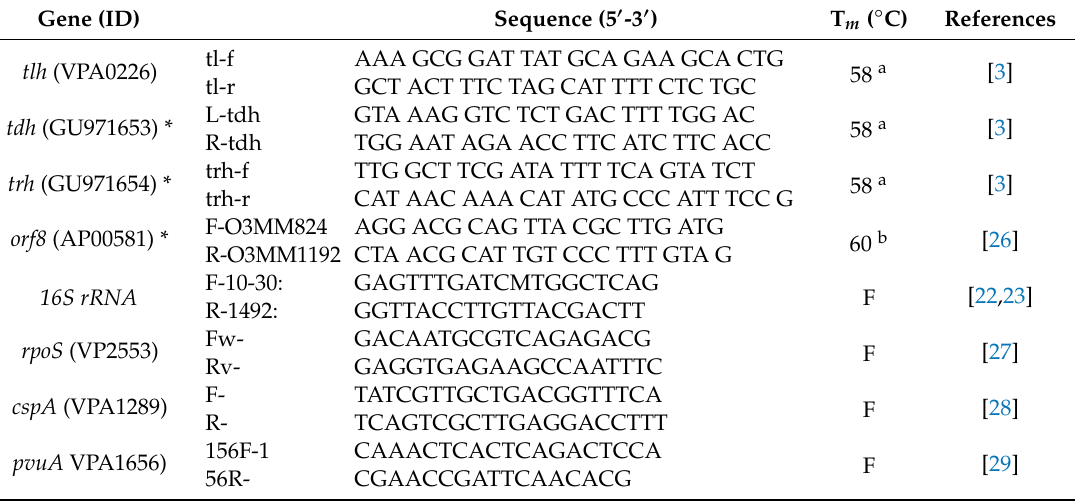
Table 1. Primers used for molecular analysis of nonpathogenic and pathogenic genes and